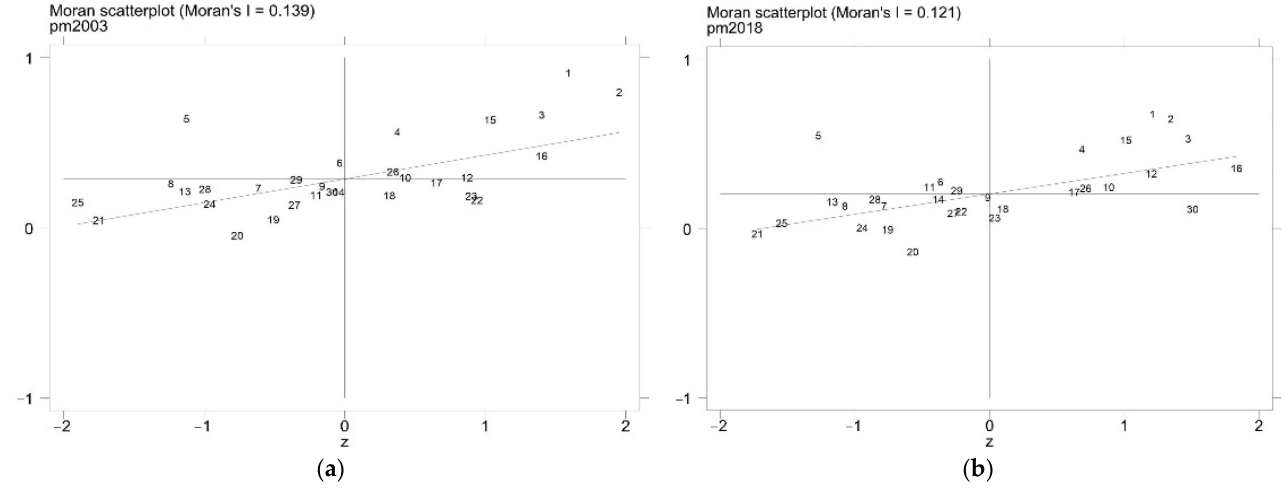
Figure 2. PM2.5 Moran scatter plot. ( a ) 2003. ( b ) 2018.